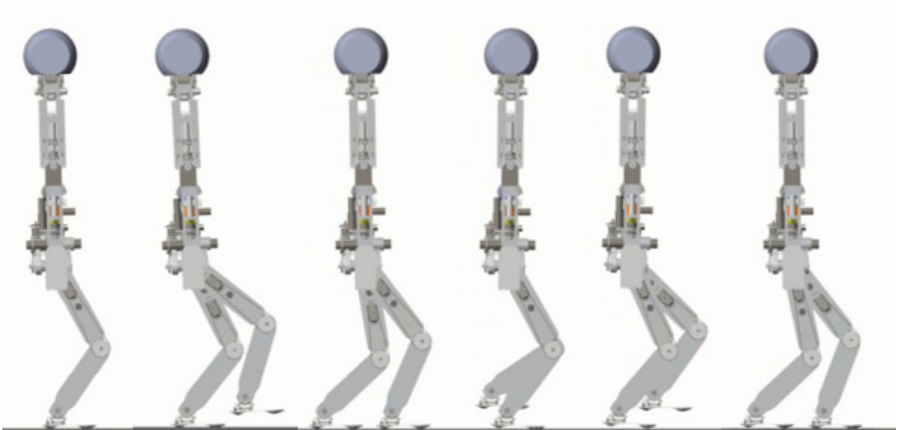
Figure 16. Snapshots of the first simulation: the biped walks on level ground.